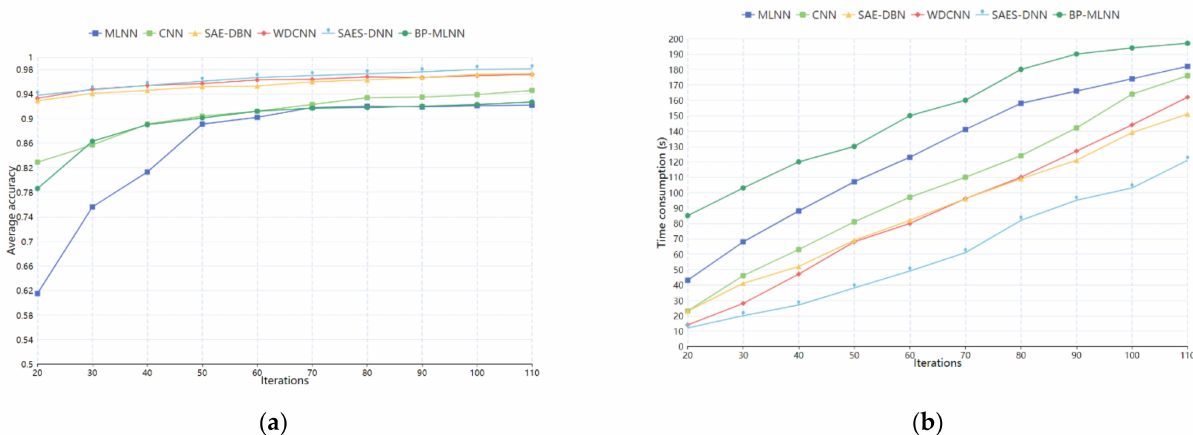
Figure 5. A comparison chart of accuracy ( a ) vs. time consumption ( b ) of different models in different learning times under the same data set. For ( a ), every 10 learning cycles was a statistical index for calculating the accuracy of the learning model; for ( b ), the training time of the model was calculated for every 10 additional learning